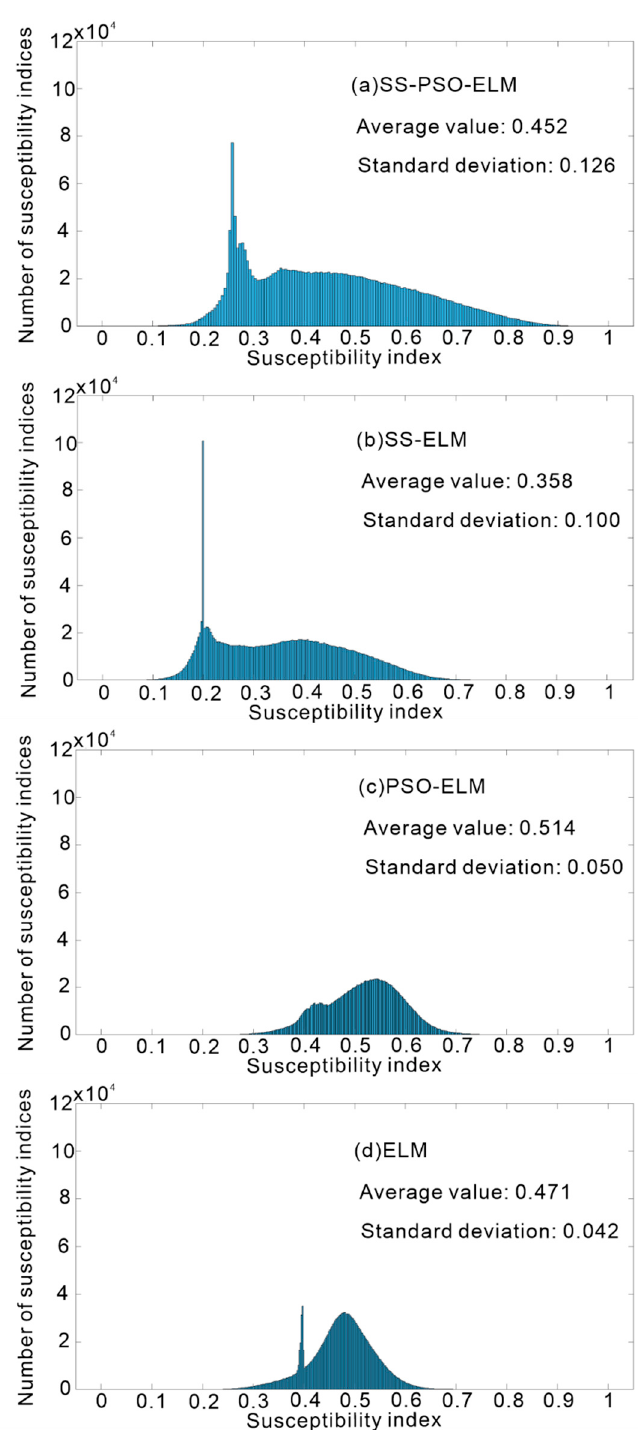
Figure 12. Distribution map of landslide susceptibility index.